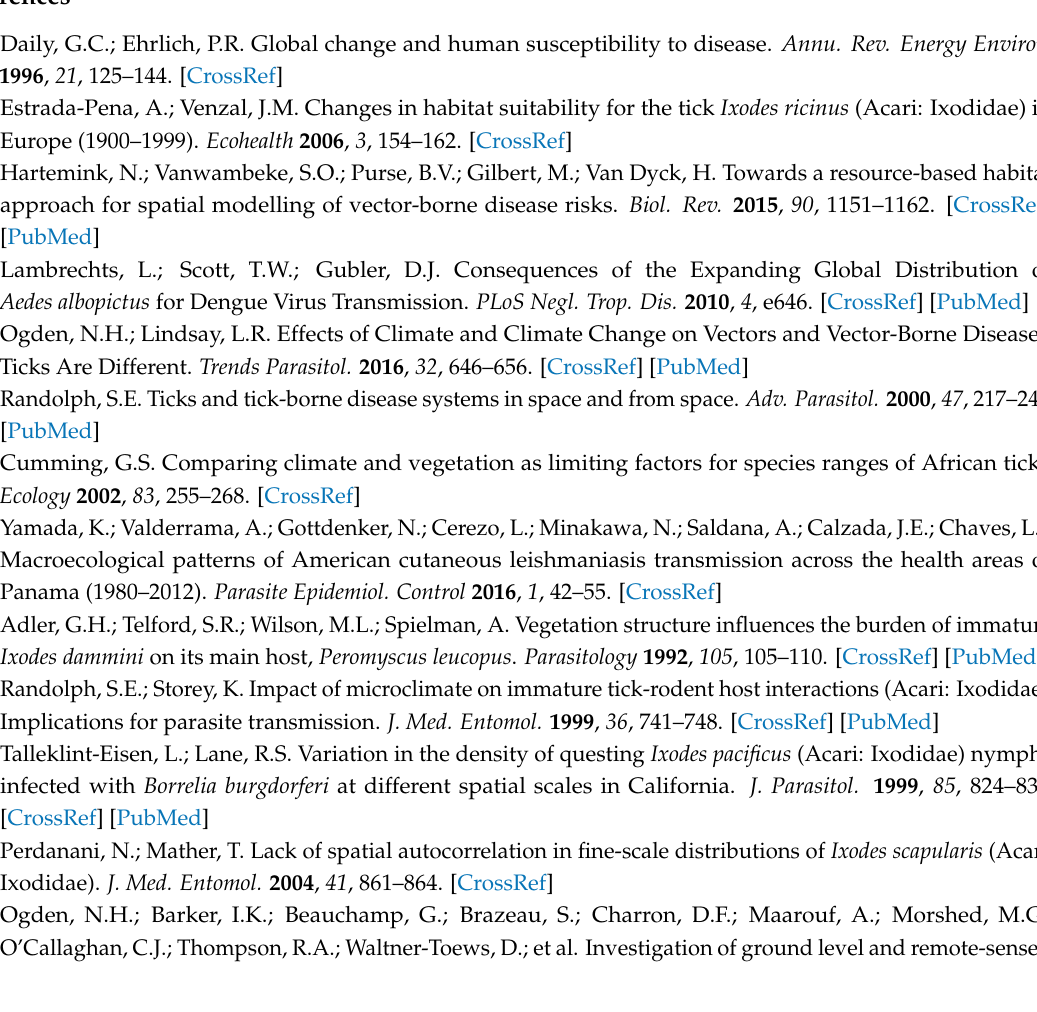
Figure S1: Abundance of each tick species in this studied at five sites samples in 2013 (x-axes) and 2014 (y-axes); shading represents 95% confidence interval around line of best fit. Sampling methodology was identical in both years. Abundance of I. scapularis in 2013 was significantly (r = 0.95, p = 0.01) correlated with